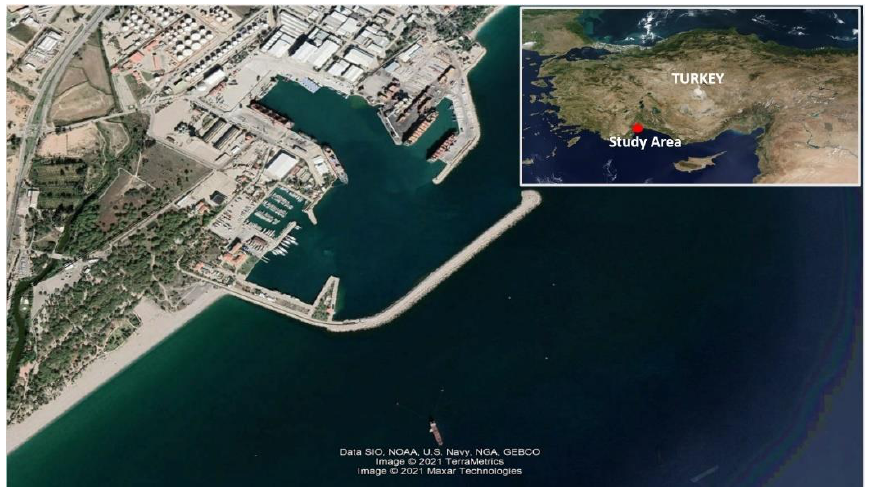
Figure 1. Location of the study area.